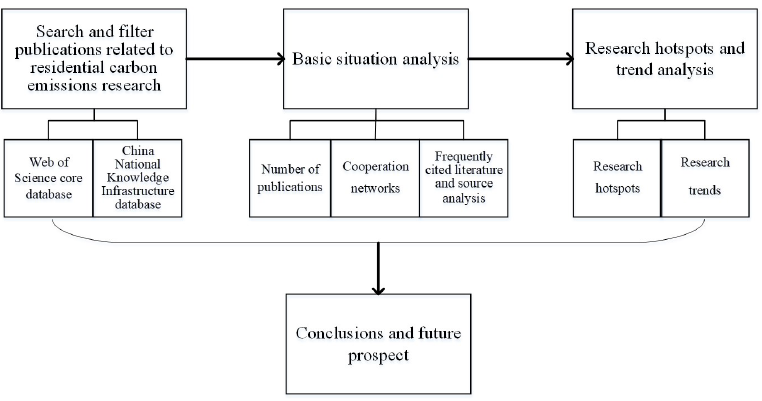
Figure 1. The research framework of this